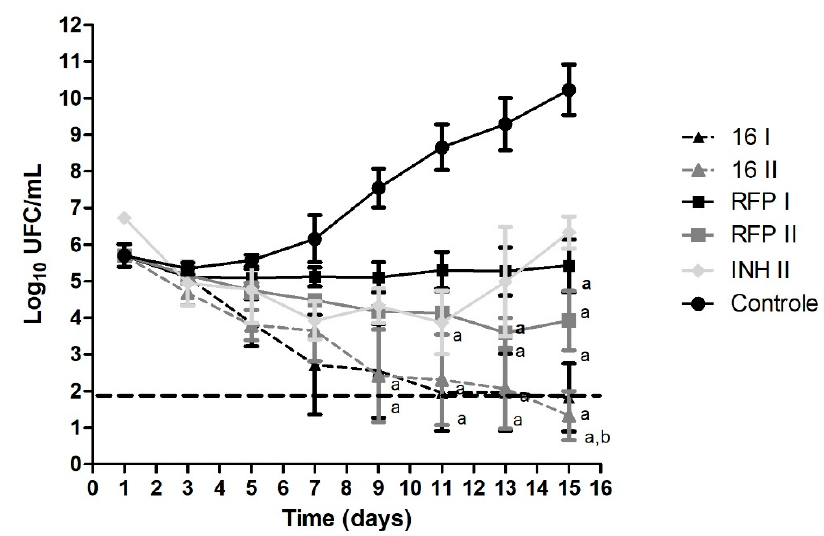
Figure 4. Time-kill curve of hydrazone 16 at 1 × (16 I) and 2 × (16 II) MIC and controls: rifampicin (RFP) 1 × and 2 × MIC, isoniazid (INH) 2 × MIC, and negative control (control). Dotted line represents reduction of 3 log 10 CFU/mL. Statistical analysis was performed using Prism 5.0. The data were analyzed using one-way analysis of variance, followed by Newman–Keels post-hoc test. The results are presented as the mean ± standard deviation from three independent experiments; a: p < 0.05 compared to control group. b: p < 0.05 compared to INH.